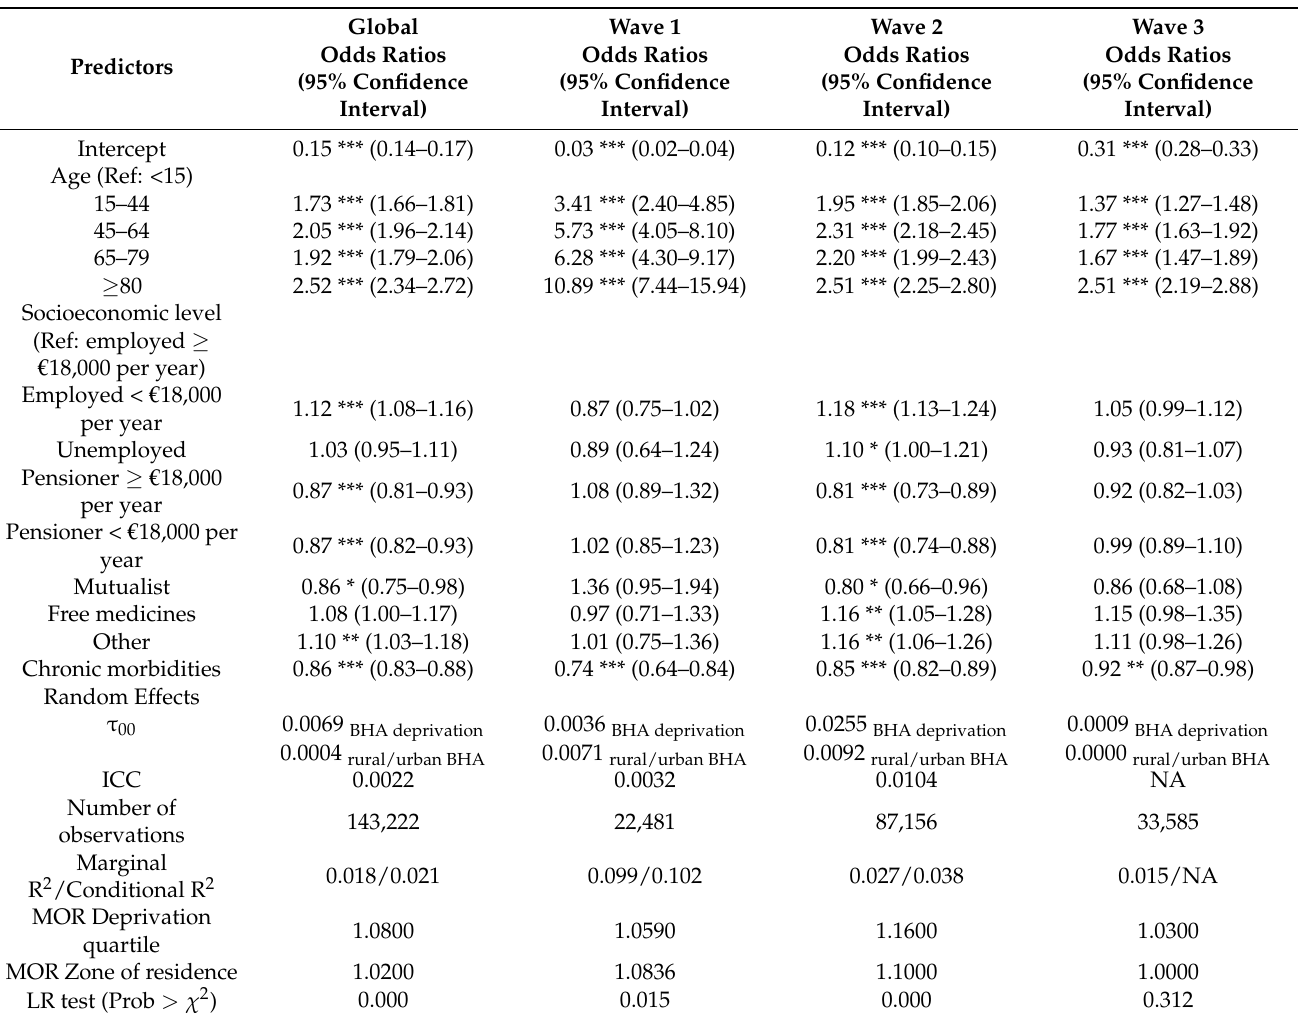
Table 4. Risk of having a COVID-19 confirmed diagnosis. Multilevel analyses in men for all the period analyzed and by